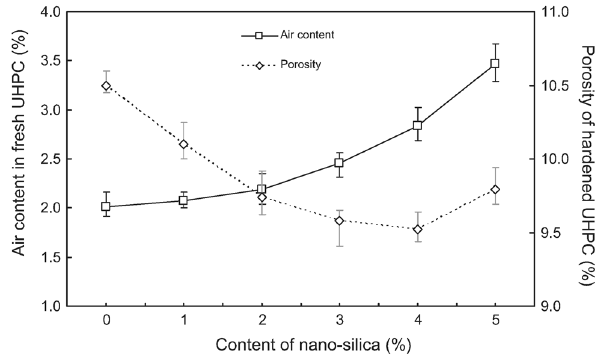
Figure 3: Air content and porosity of UHPC with di ff erent quantities of nano - silica [ 34 ]